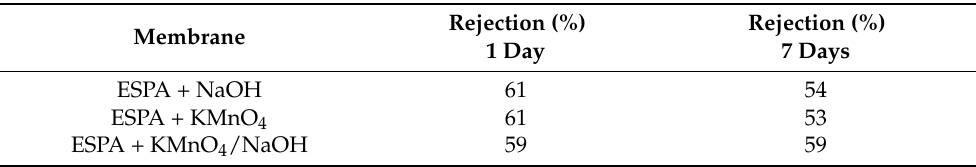
Table 6. Rejection of organic matter using regenerated